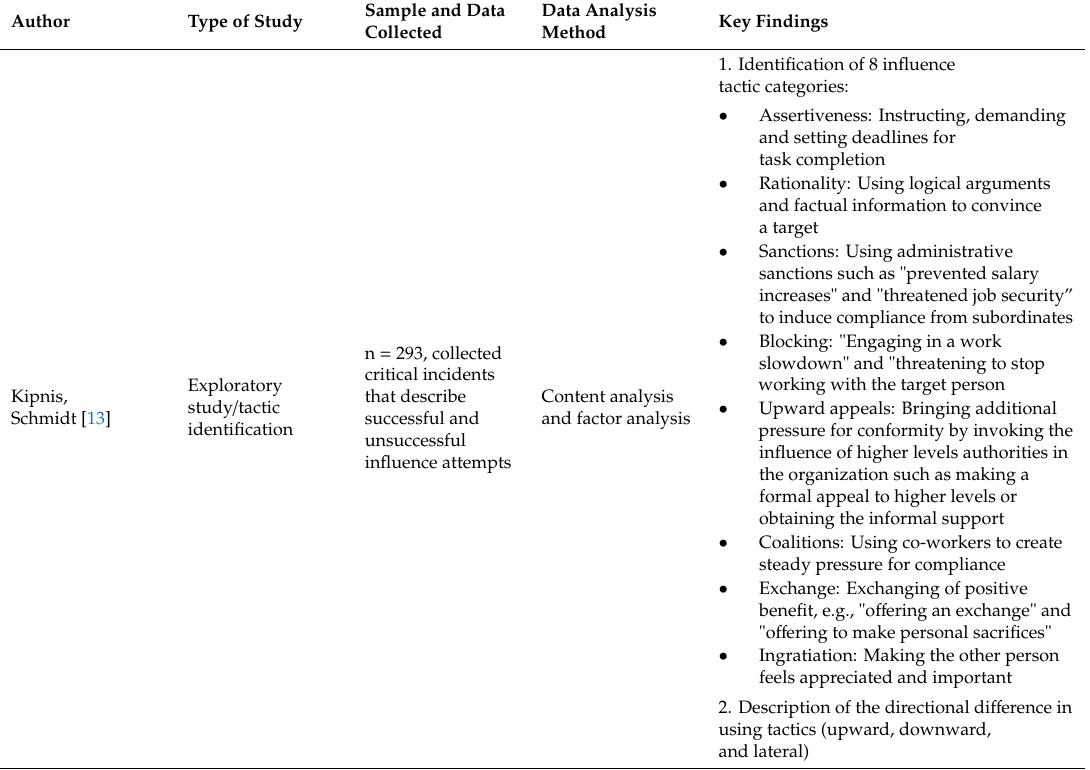
Table 1. Prior research on influence tactic identification and validation (in chronological